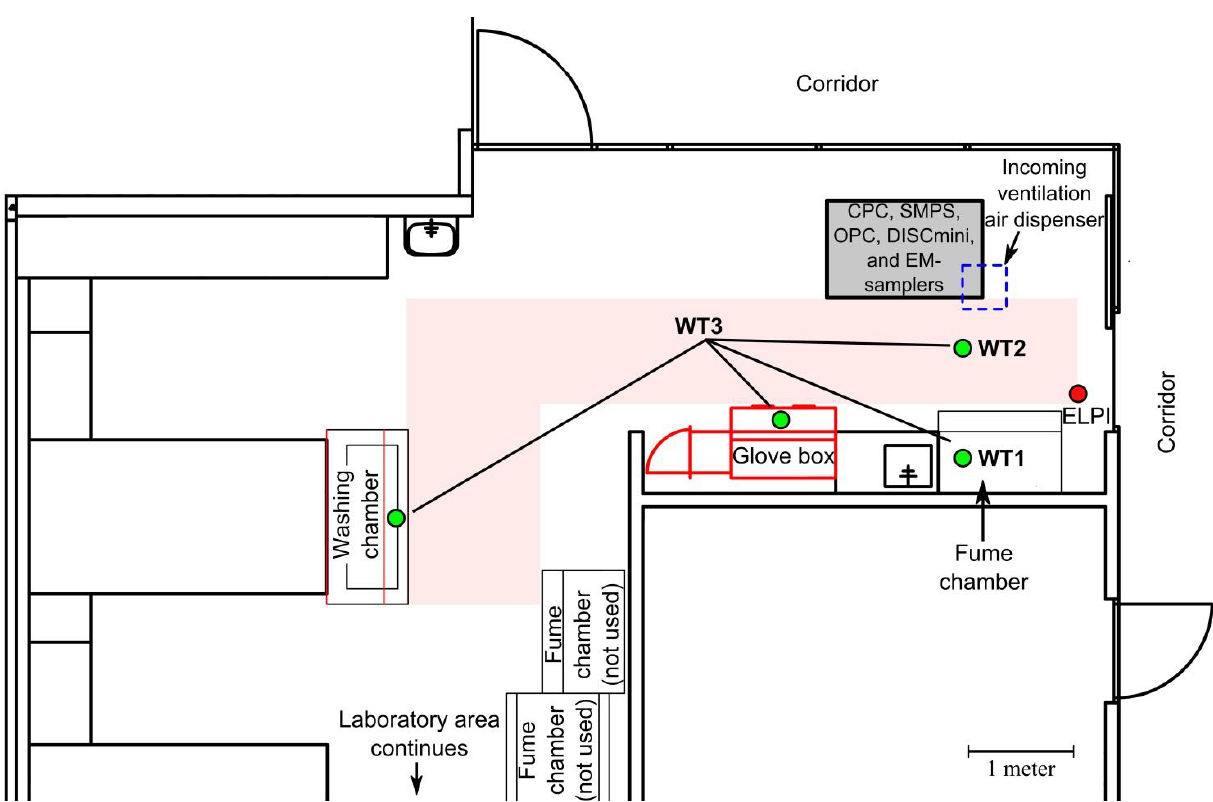
Figure 2. Layout of the work area. Light red shows the ND handling area during work